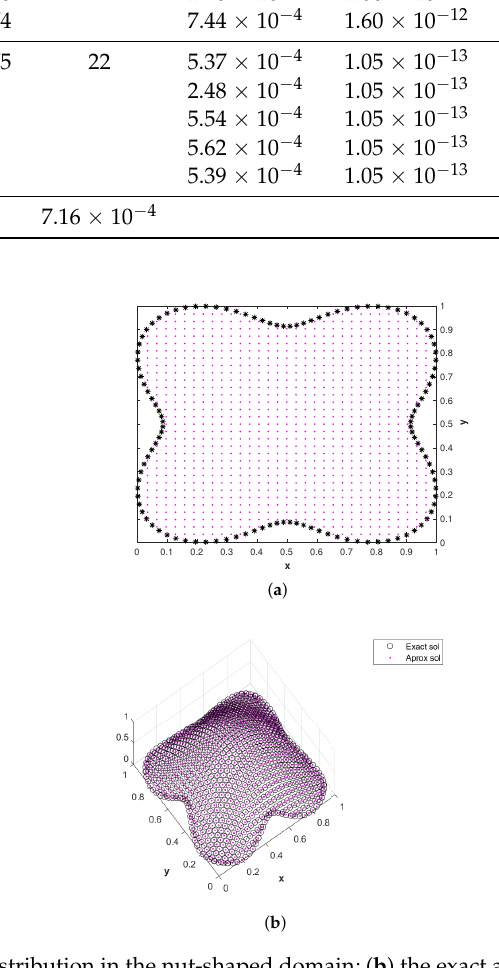
Figure 3. ( a ) Node distribution in the nut-shaped domain; ( b ) the exact and numerical solutions in the nut-shaped domain.